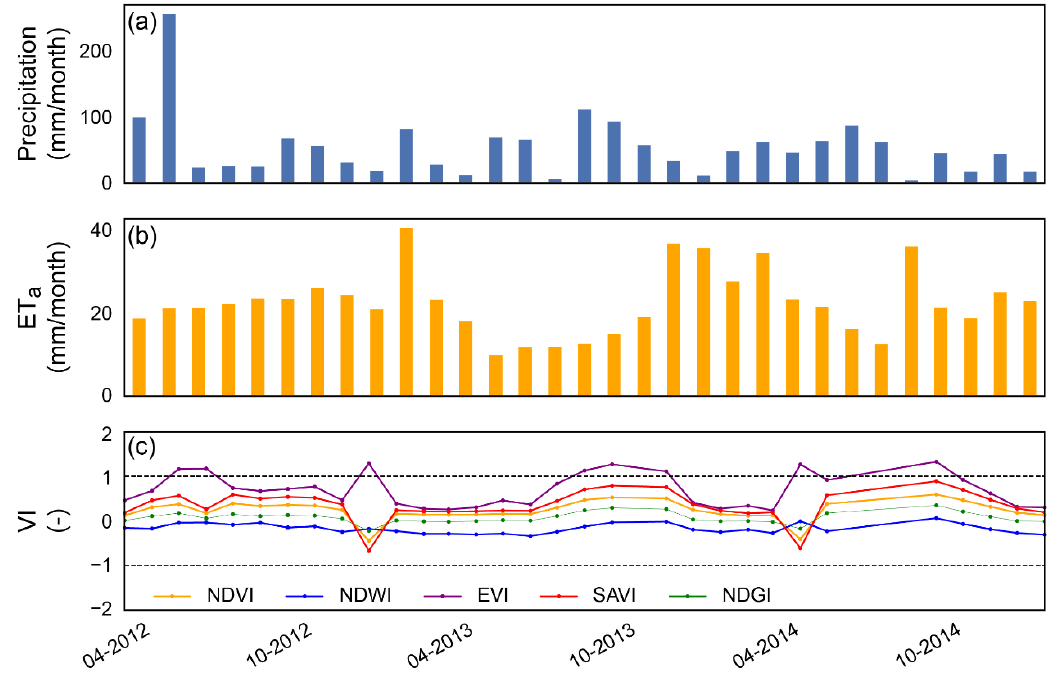
Figure 6. Temporal evolution of monthly precipitation ( a ), monthly ET a ( b ), and monthly VIs ( c ) in AU-Ync.